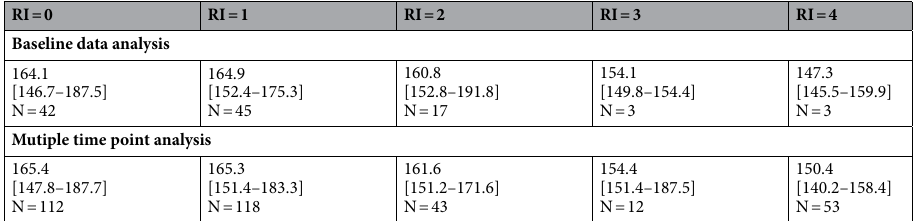
Table 4. Association of PLXNA4 plasma levels with Respiratory Index (RI) in COVID-19 patients from the COMMUNITY study. Shown values shown correspond to PLXNA4 median [1st–3rd quartile] of relative MFI levels. Tests for association were performed on log transformed values adjusted for age, sex and body mass index using linear and linear mixed effect models for baseline and multiple time points analyses, respectively. Individuals with RI ≥ 3 tend to exhibit lower log-transformed PLXNA4 levels than individuals with RI ≤ 2, both in the baseline (β = −0.107 ± 0.082, p = 0.195) and multiple time point (β = −0.073 ± 0.033, p = 0.025) analyses